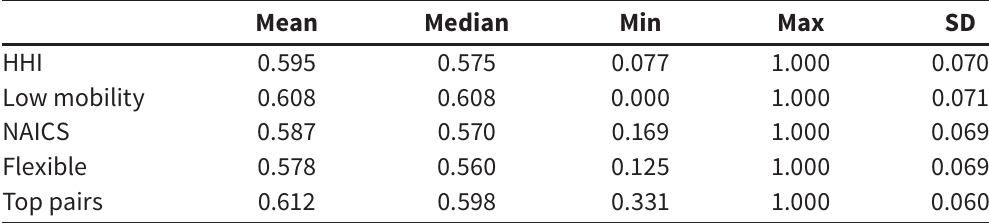
Statistics of the HHI and low mobility by method of estimation